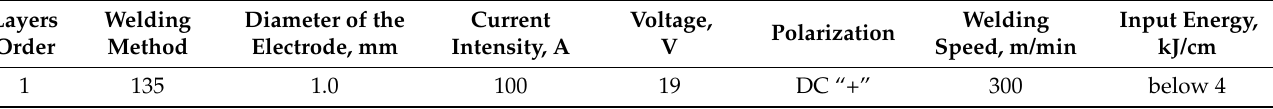
Table 1. Welding parameters of S700MC